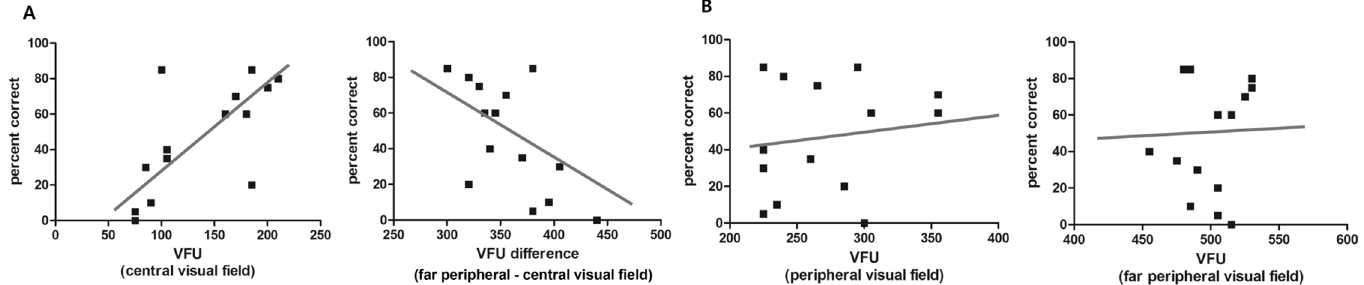
Fig 7. Correlation analysis of visual field with speech perception performance. (A) VFU of central visual field and VFU difference between central and far peripheral visual field showed statistically significant correlation with PB word score. VFU of central visual field showed significant positive correlation ( r = 0.669, P = 0.009, Spearman correlation test). However, VFU difference showed significant negative correlation with PB word score ( r = -0.593, P = 0.025). (B) VFU of peripheral and far peripheral visual field did not have significant correlation with the PB word score (r = 0.143, P = 0.626 and r = 0.100, P = 0.734, respectively).